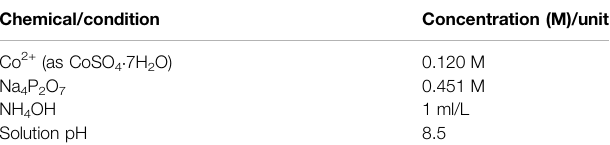
TABLE 2 | Bath compositions (unless otherwise noted) for Co-pyrophosphate solution (M (cid:1) mol dm − 3 ). Chemical/condition